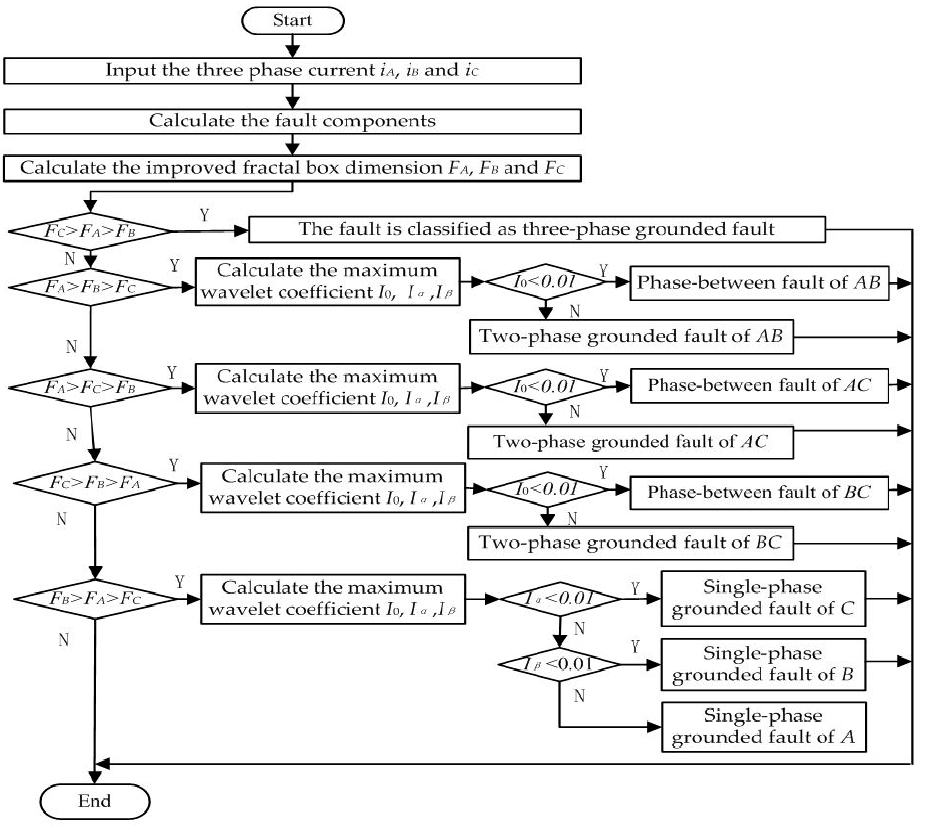
Figure 5. Flow chart of the fusion sensing (FS) method.